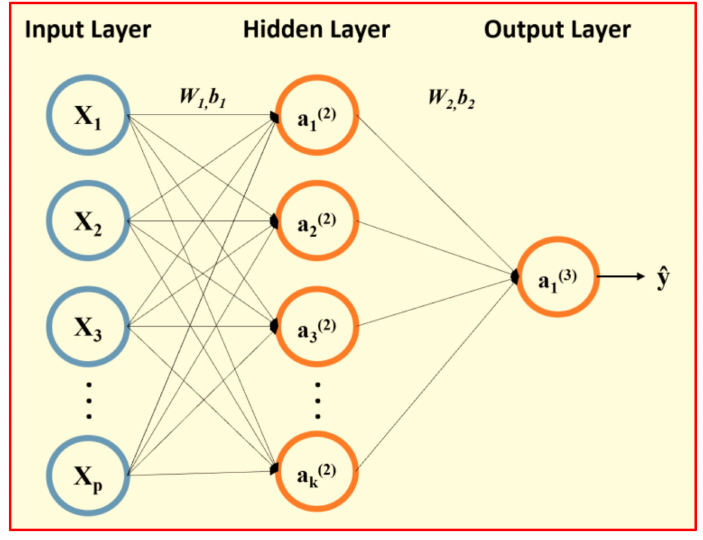
Figure 6. General structure of an artificial neural network with three input and hidden